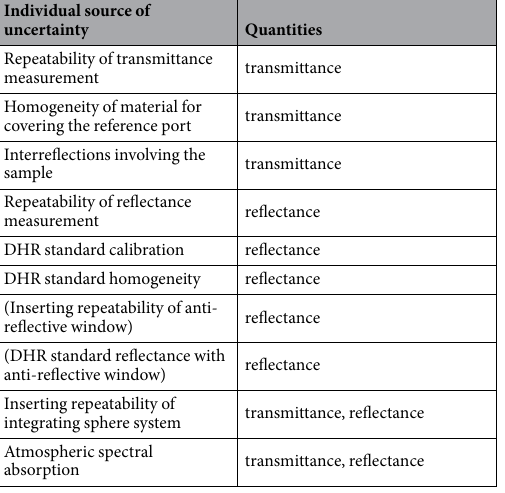
Table 1. Uncertainty sources of transmittance and reflectance